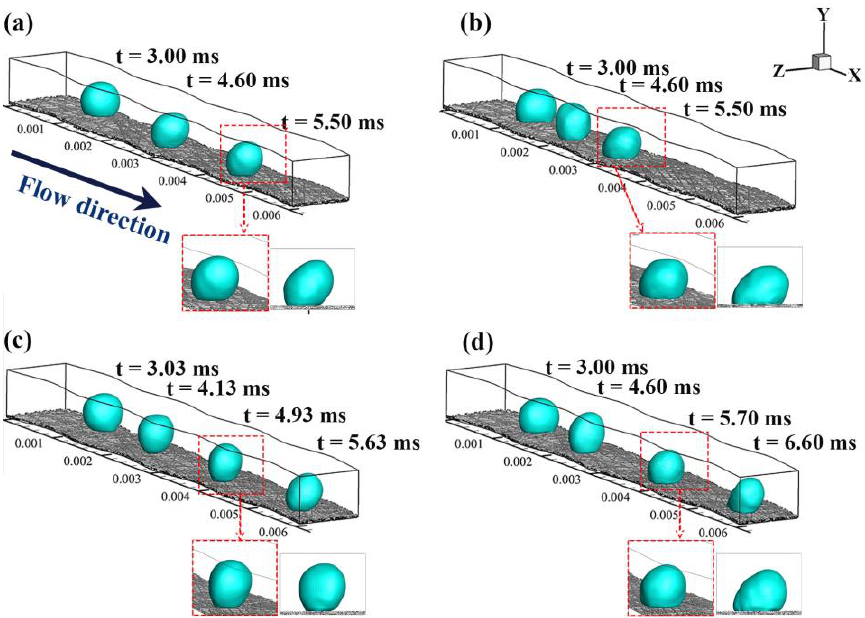
Figure 9. GDL contact angle e ff ect on the surface microstructure of fiber diameter ( a ) 15 µ m at 120 ◦ , ( b ) 15 µ m at 105 ◦ , ( c ) 9 µ m at 120 ◦ and ( d ) 9 µ m at 105 ◦ with their exploded top and X-Y side view, respectively.